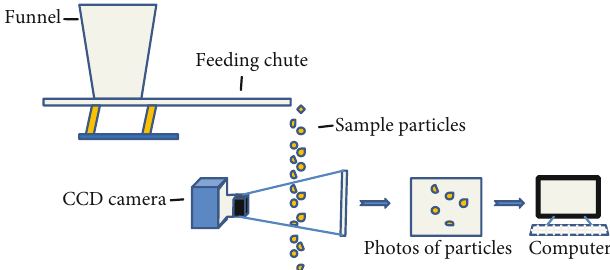
Figure 2: The working principle of dynamic image analyzer.